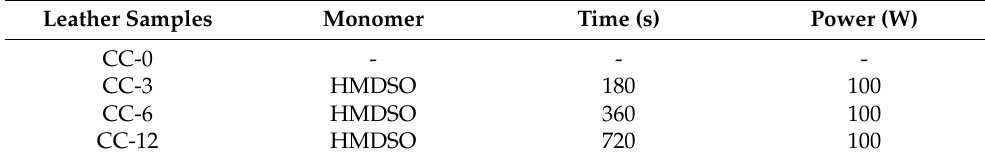
Table 1. Samples nomenclature according to the operating conditions of the plasma coatings